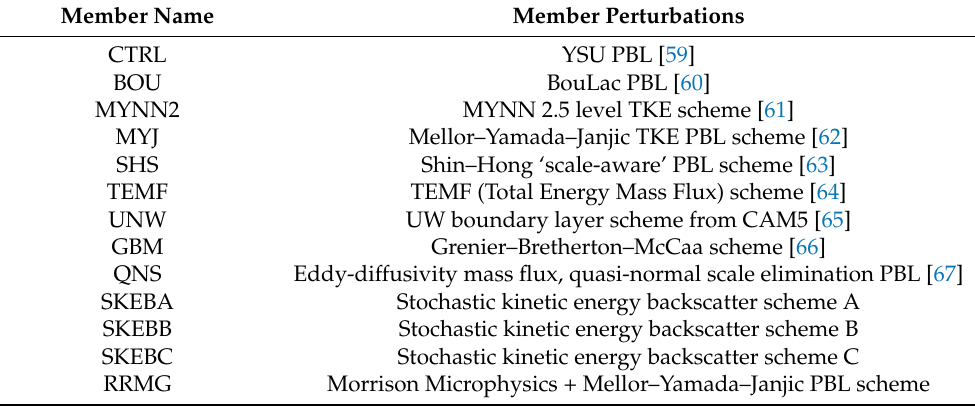
Table 1. Mesoscale ensemble prediction member names and parameterization scheme